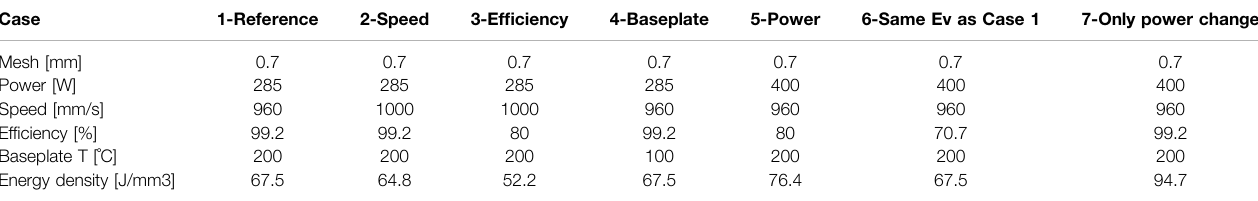
TABLE 4 | Seven cases of different combination of process parameters studied by the Simufact Additive simulations.